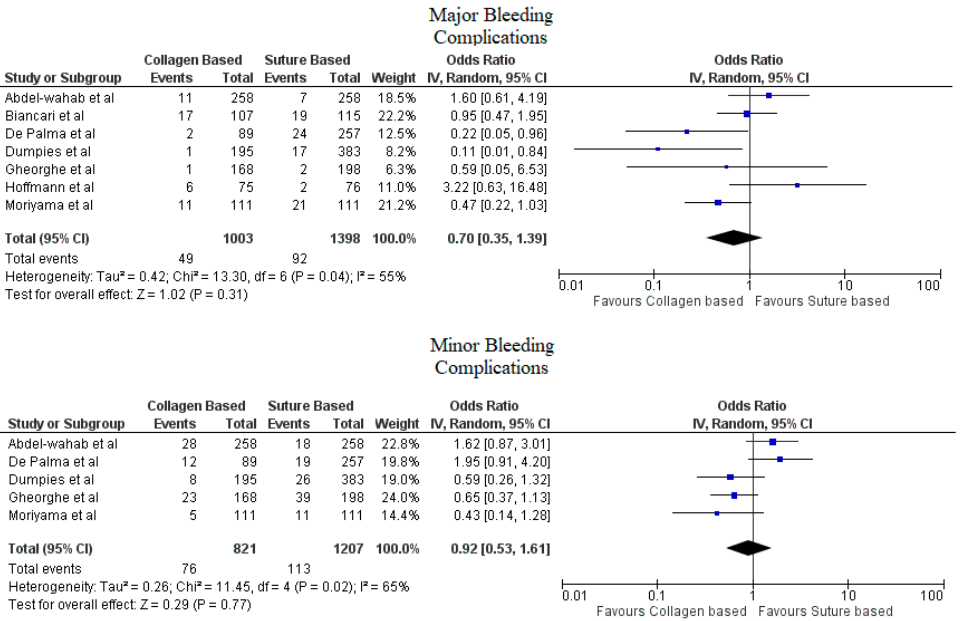
Figure 2. Forest plot for comparison of major and minor bleeding complications between collagen vs. suture-based vascular closure devices for large bore arteriotomies, CI: confidence interval, IV: Instrumental variable.